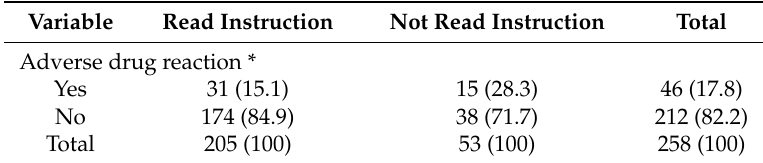
Table 3. Adverse drug reaction and whether the instructions were read or not (person (%)). Variable Read Instruction Not Read Instruction Total Adverse drug reaction * Yes 31 (15.1) 15 (28.3) 46 (17.8) No 174 (84.9) 38 (71.7) 212 (82.2) 205 (100)